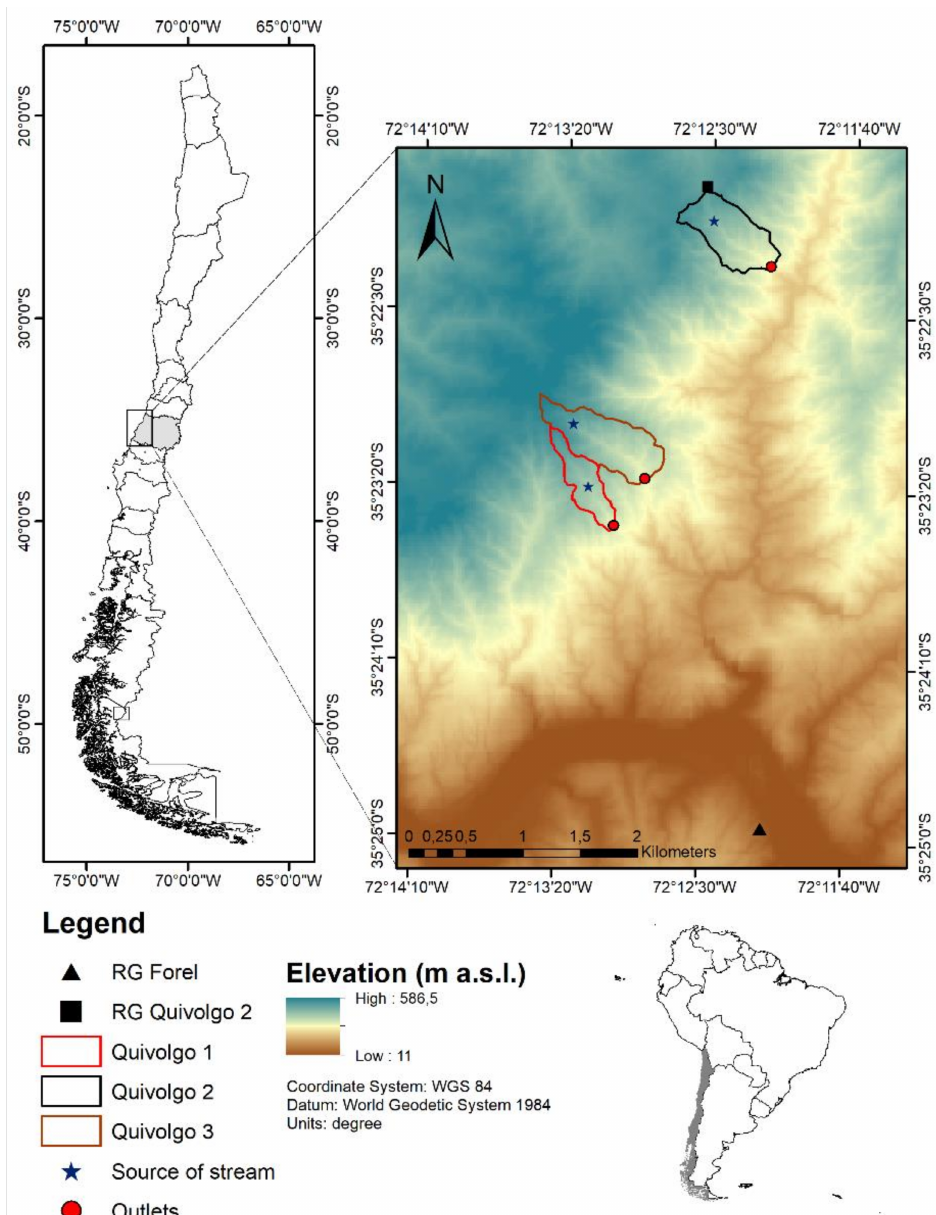
Figure 1. Catchment location and sampling points within the study site. RG: rain gauge. Rainfall was recorded using a rain gauge at the top of Q2, and a second gauge at the site of Forel, around 4 km southeast of the catchments (Figure 1). The gauge at the top of Q2 was used as the primary source. The relationship between the gauge at Q2 and the weather station at Forel was used to estimate rainfall at the catchments if data from either location was available. For the periods where neither the gauge at Q2 nor at Forel were operating, data obtained from nearby stations maintained by the General Directorate of Water (DGA) at Nirivilo was used to estimate rainfall at the catchments, using linear regression as in